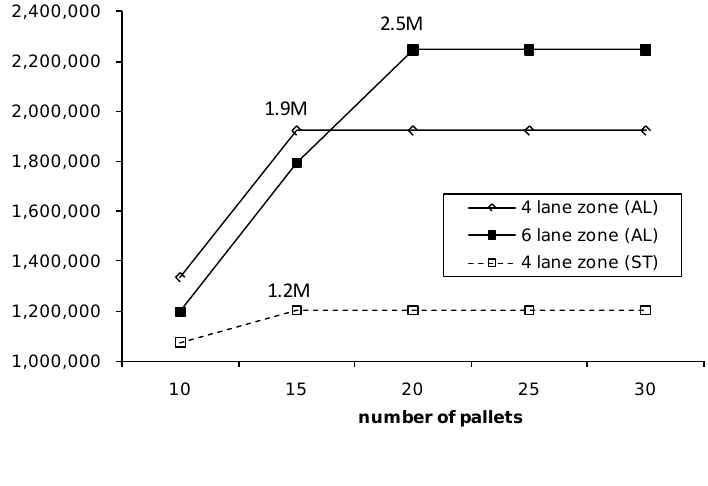
Figure 11. “Product mix”. Source: